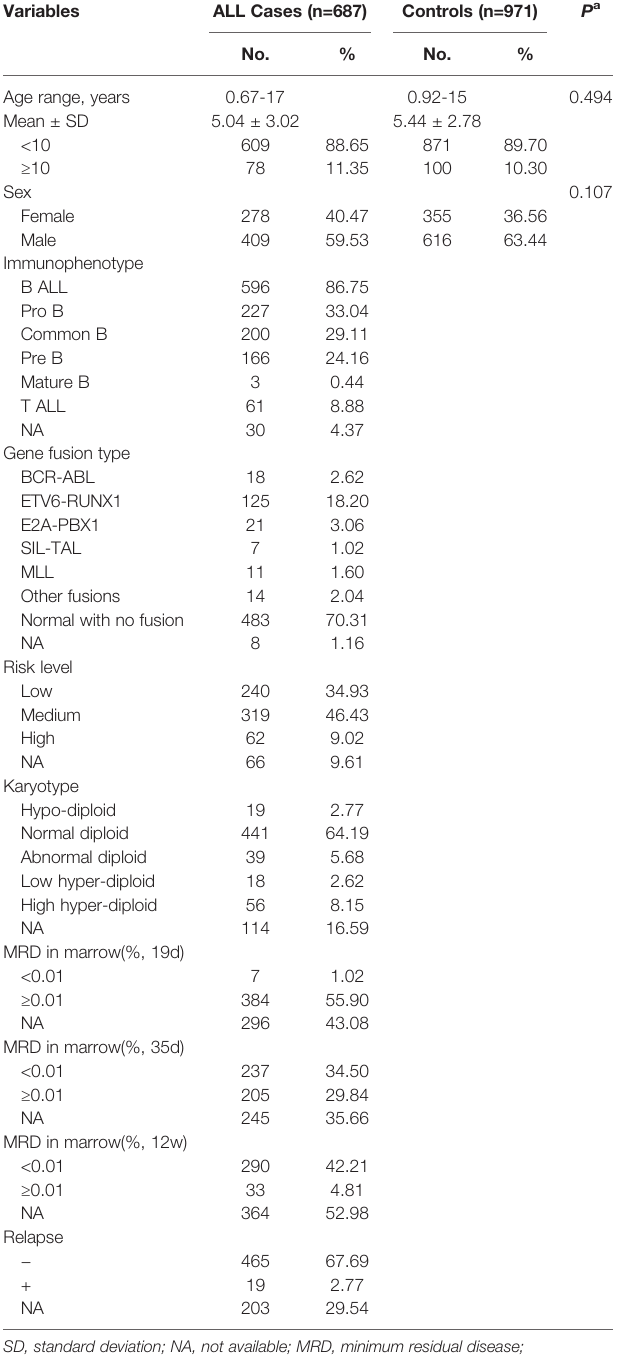
TABLE 1 | Frequency distribution of selected characteristics in ALL cases and cancer-free